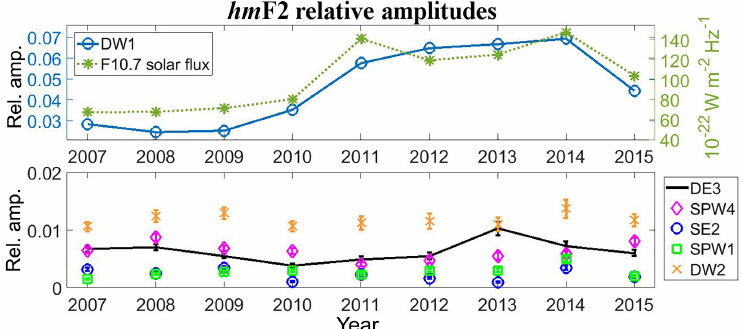
Figure 5. hm F2 relative amplitudes for periods around September equinoxes from 2007 to 2015. The same waves amplitudes plotted in the Fig. 3 were considered here for the same reasons pointed earlier. F10.7 solar flux is plotted in the top graph with the DW1 relative amplitude. The results show different results showed in the Fig.